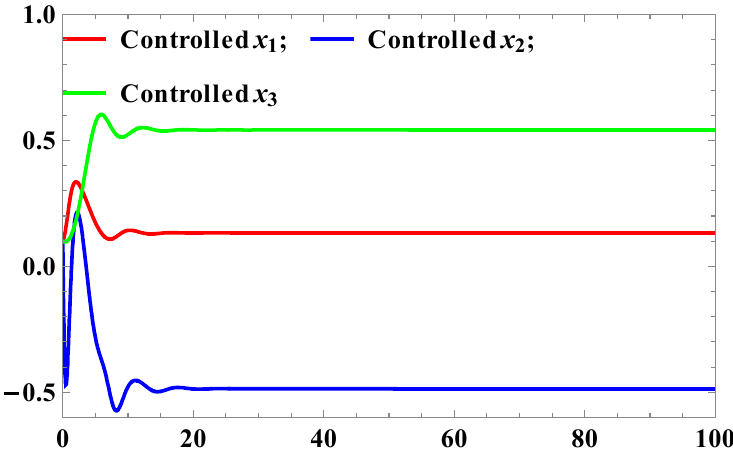
Figure 3. Time series of uncontrolled x 1 , x 2 , and x 3 .